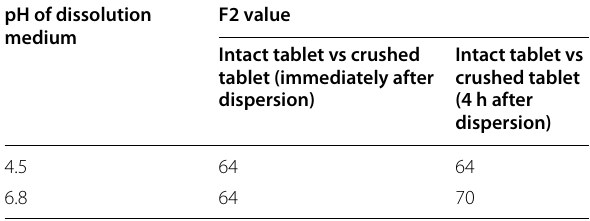
Table 3 Statistical comparison between intact and crushed 10 mg vericiguat tablet (in 900 mL acetate buffer at 37°C at 75 rpm) expressed as F2 value for each pair pH of dissolution F2 medium